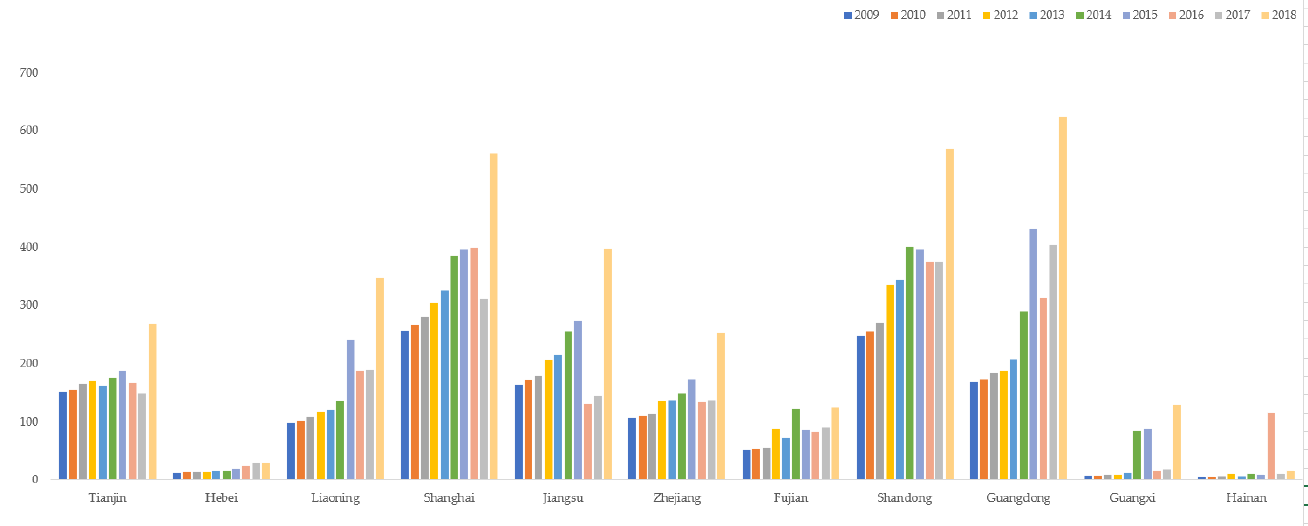
Figure 3. Marine technology input chart.